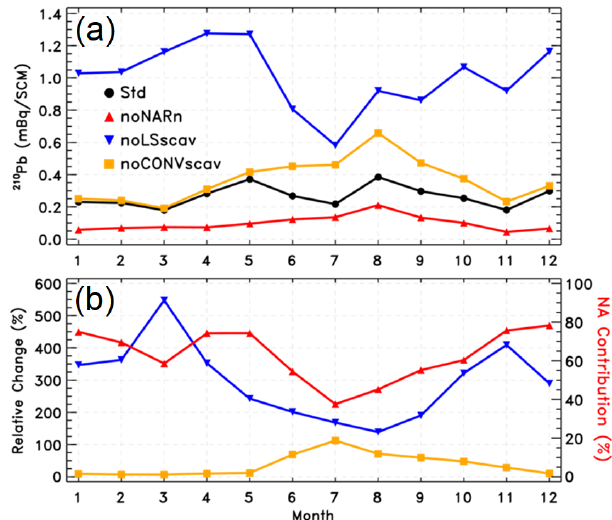
Figure 9. Simulated monthly surface 210 Pb tracer concentrations of submicron milliBecquerels (mBq) per standard cubic meter of (dry) air (mBqSCM − 1 ) at Bermuda (32.31 ◦ N, 64.75 ◦ W) in 2017 as a way to assess effects of precipitation scavenging on North Ameri- can outflow. Panel (a) shows monthly mean surface 210 Pb concen- trations in the standard simulation (Std) and three sensitivity simu- lations, i.e., without North American 222 Rn emissions (noNARn), without large-scale precipitation scavenging (noLSscav), and with- out convective precipitation scavenging (noCONVscav). Panel (b) shows percentage changes, i.e., (noLSscav-Std) / Std × 100 in blue and (noCONVscav-Std) / Std × 100 in orange, and the North Amer- ican contribution in red, i.e., (Std-noNARn) / Std ×